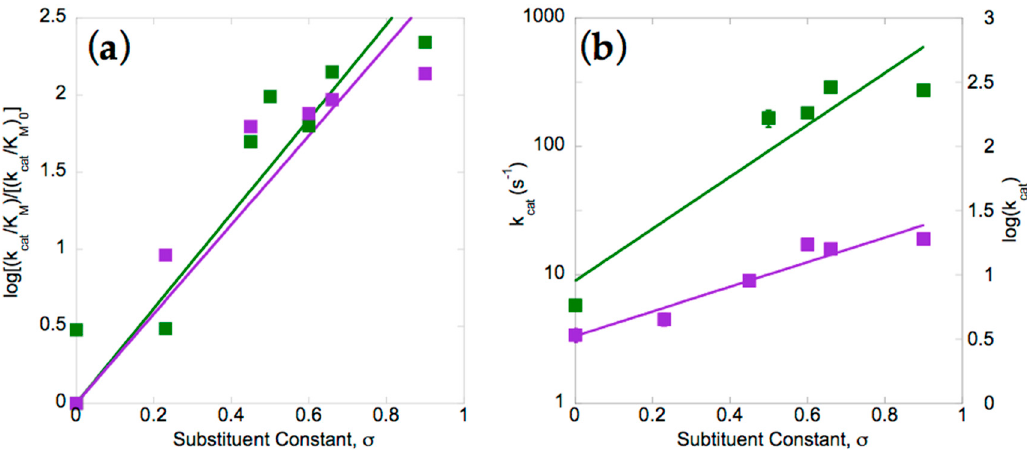
Figure 3. Dependence of enzymatic reaction rates on para Hammett constant, for St NfsB (green) and Ms PnbA (purple) [77]. ( a ) The second-order rate constant ( k cat / K M ) for each substituted substrate was divided by the value obtained for (unsubstituted) nitrobenzene before taking the log to get log[( k cat / K M )/( k cat / K M ) 0 ], which was plotted against the Hammett para substituent constant σ . Log[( k cat / K M )/( k cat / K M ) 0 ] plots yielded ρ values of 3.1 ± 0.2 ( St NfsB, R 2 = 0.86) and 2.9 ± 0.2 ( Ms PnbA, R 2 = 0.83); ( b ) the first-order rate constants are plotted without normalization, yielding for St NfsB a slope of 2.4 ± 0.4 and an intercept of 0.9 ± 0.3 (R 2 = 0.88), and for Ms PnbA a slope of 1.0 ± 0.1 and intercept of 0.5 ± 0.08 (R 2 = 0.92). See Methods for the equation and also Supplemental Table S2 and Figure S4